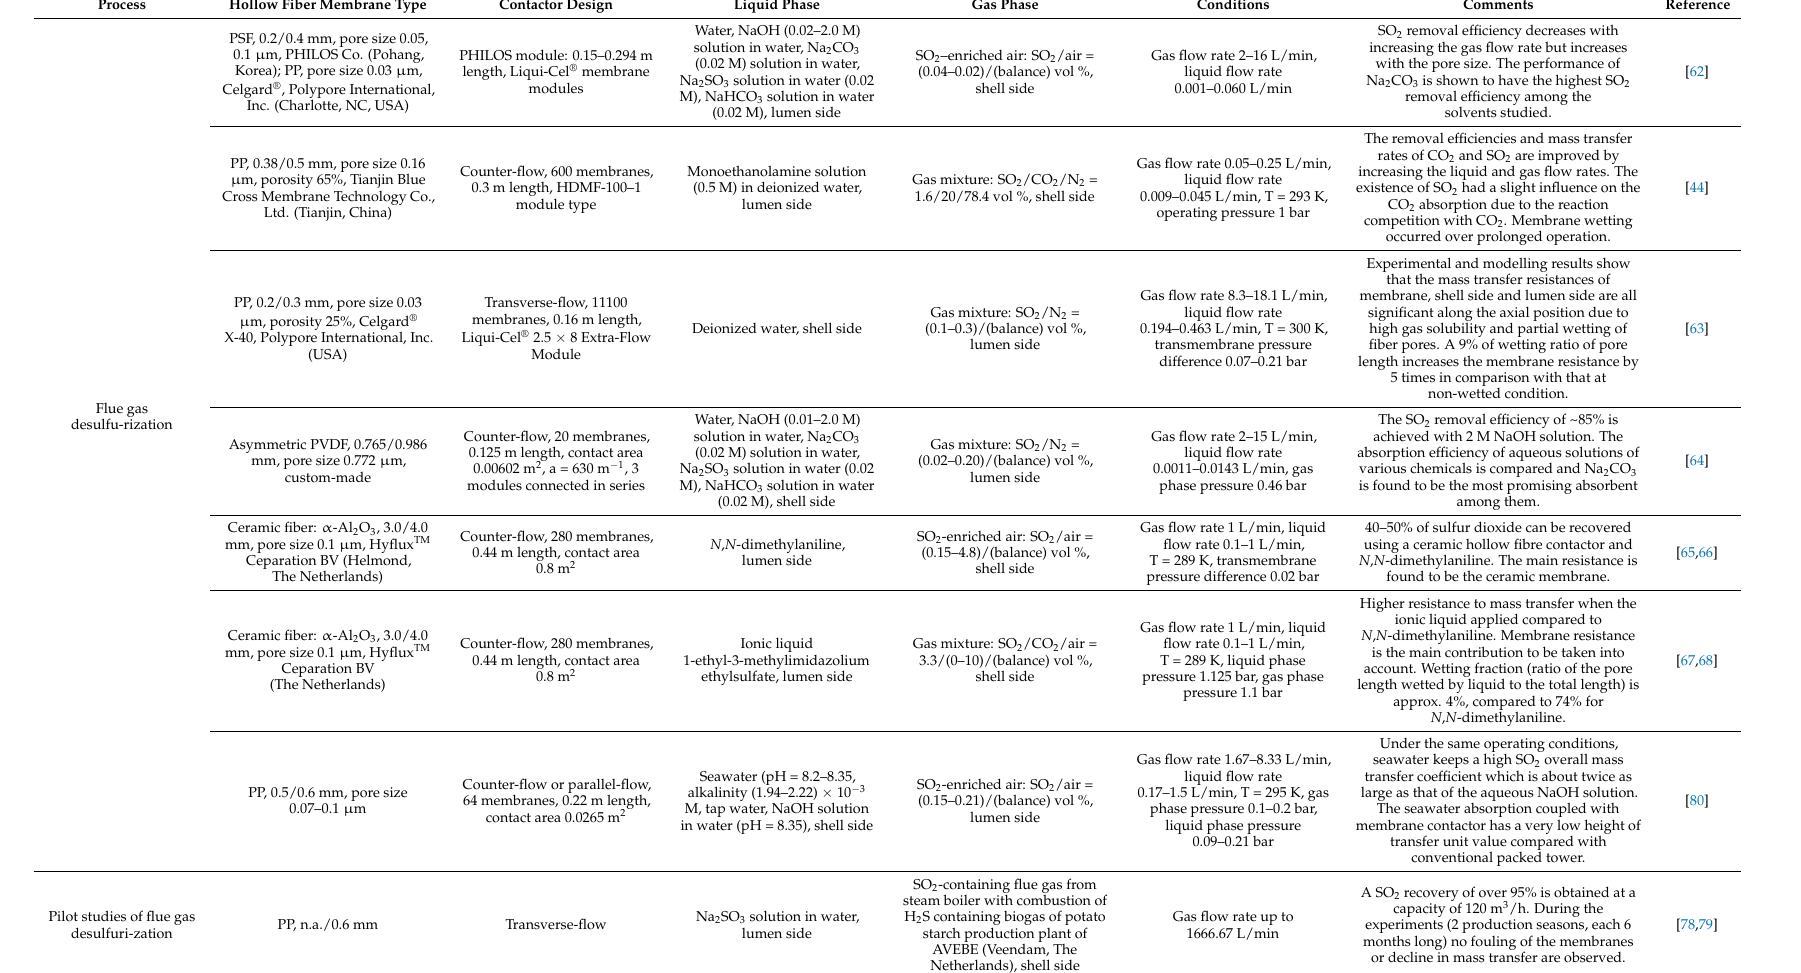
Table 3. Studies on sulfur dioxide